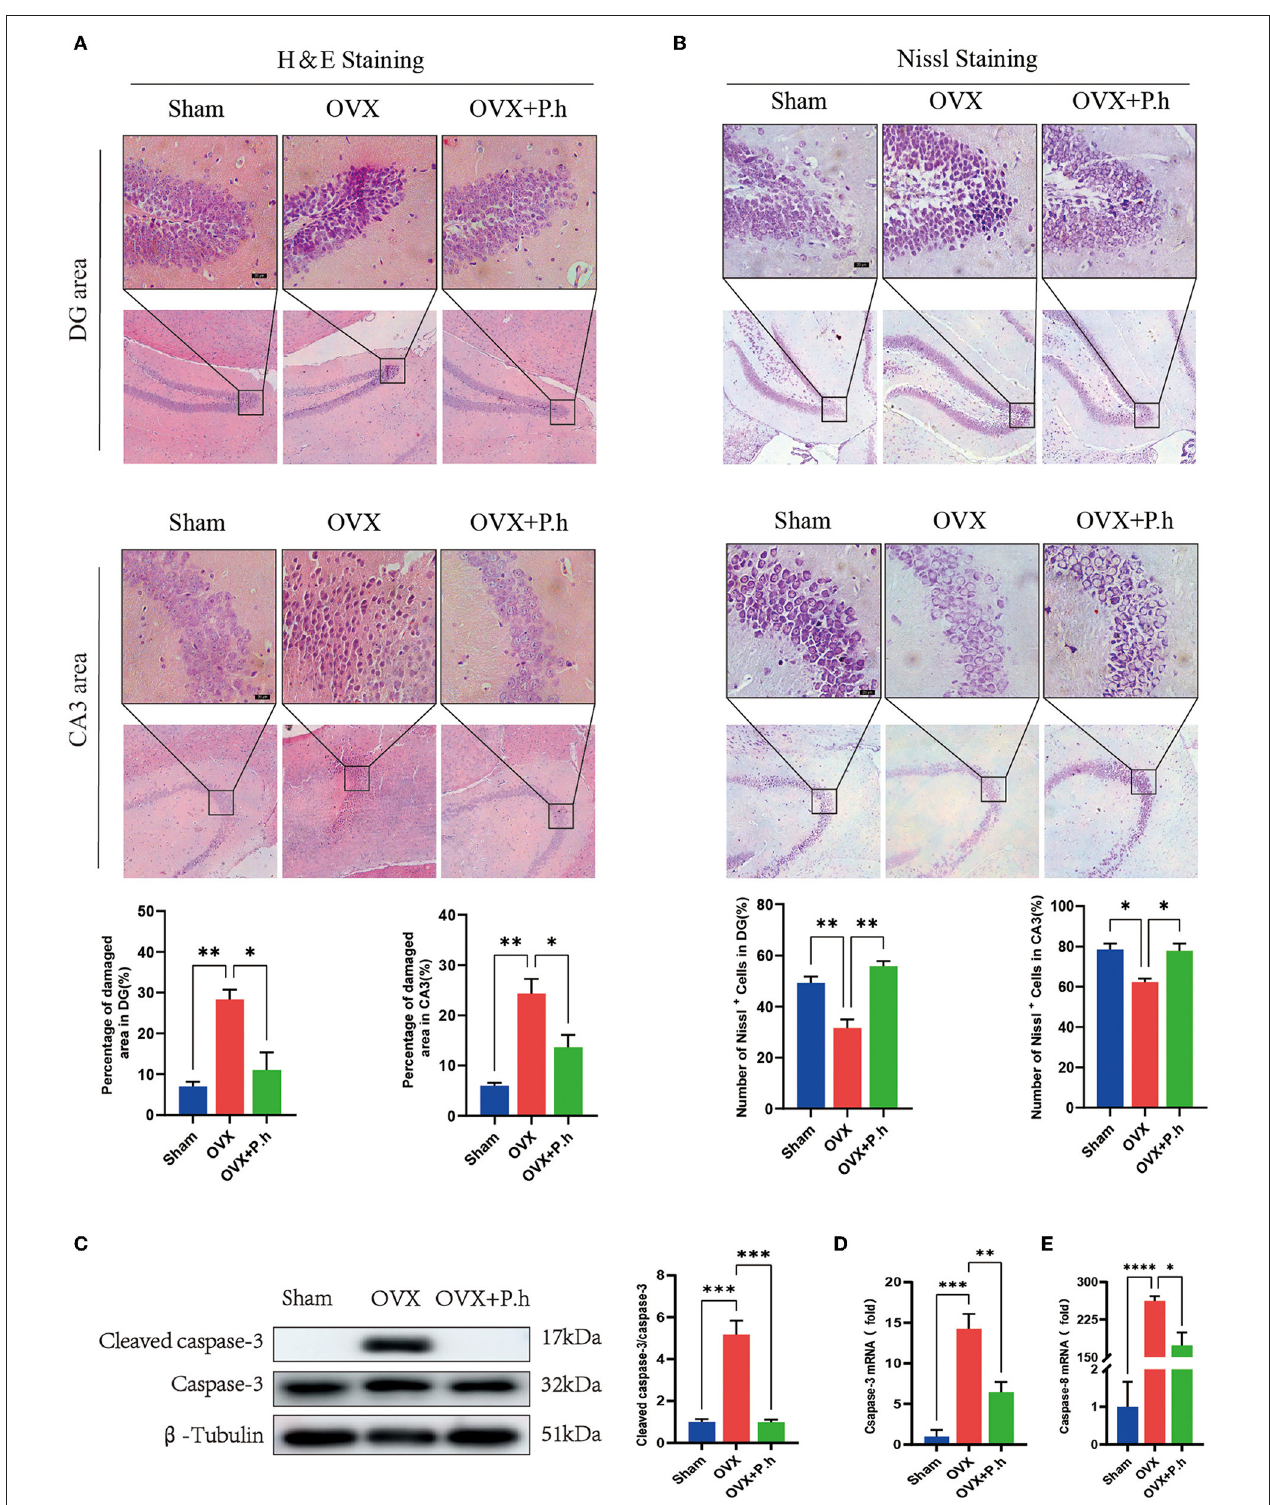
FIGURE 2 | P. histicola reduced hippocampal injury and neuronal apoptosis in OVX mice. (A) H & E staining and its quantifications. Magnification 100 × and 400 × . Scale bar = 20 µ m. (B) Nissl staining and its quantifications. Magnification 100 × and 400 × . Scale bar = 20 µ m. (C) Cleaved caspase-3 protein level and the ratio of cleaved caspase-3 to caspase-3 in hippocampus. (D,E) . The mRNA expression of caspase-3 (C) and caspase-8 (D) detected by qRT-PCR. Data are presented as means ± SEM ( n = 4/group). * p < 0.05, ** p < 0.01, *** p < 0.001, **** p < 0.0001.